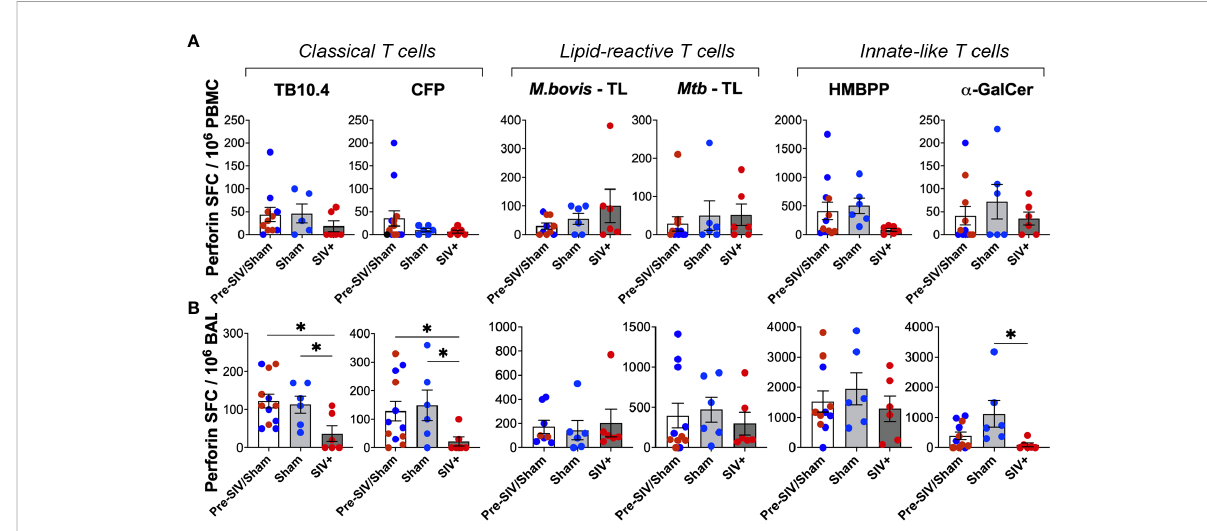
FIGURE 9 No impact of chronic SIV infection on Perforin production by lipid-reactive T cells in BAL fl uid. Quanti fi cation of Perforin producing cells expressed as SFU/million cells, following stimulation with TB10.4 peptide pool, M.bovis CFP, M.bovis and Mtb TL fractions, HMBPP, and a - GalCer in freshly isolated (A) PBMCs, and (B) BAL lymphocytes. 1wk pre-SIV/sham inoculation (white bars), and 6-8 weeks post SIV/sham (grey bars) show individual macaques inoculated with either sham (blue circles) or SIV (red circles). Unpaired t test was used to compute differences between groups with respect to pre-SIV/sham baseline. Asterisks indicate signi fi cant differences between time points (*p < 0.05).